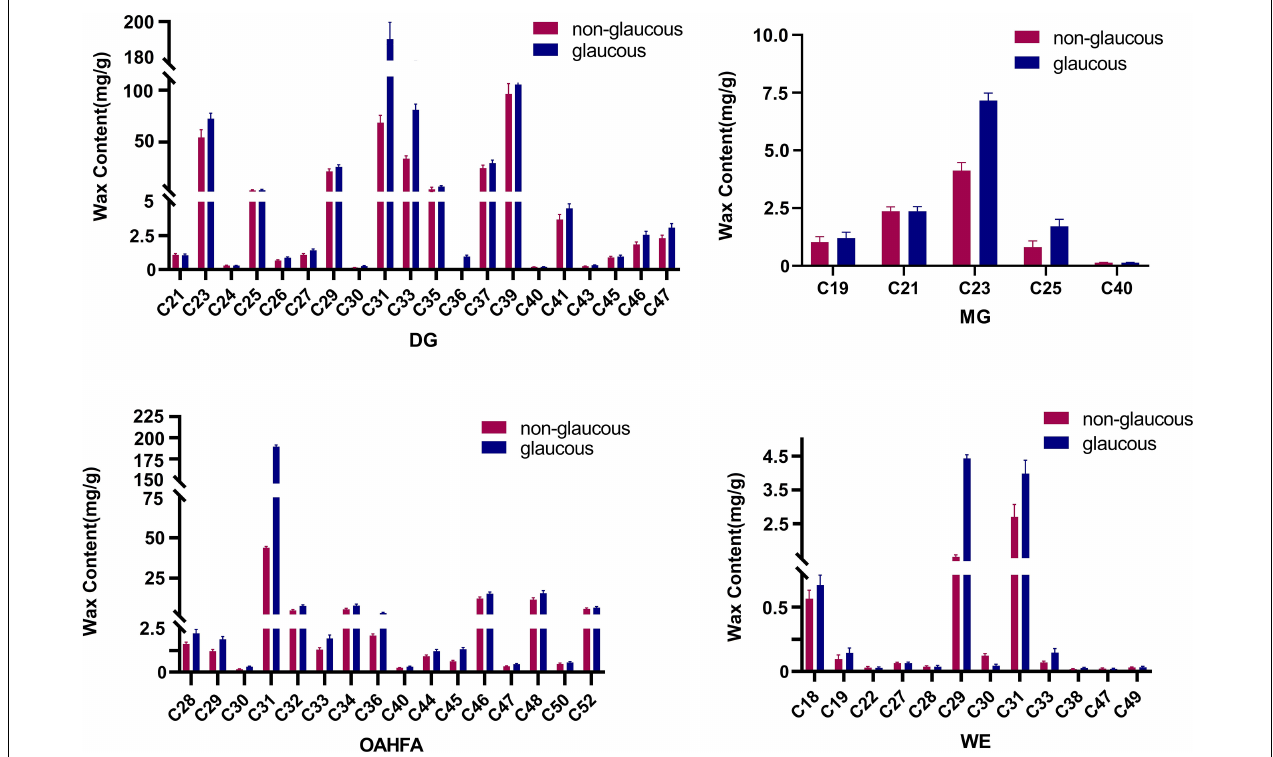
FIGURE 3 | The content of the main lipid molecules in cuticular wax of wheat flag leaves from non-glaucous Jinmai47 and glaucous Jinmai84. Major molecular species composition of DG (Diacylglycerols), MG (Monoradylglycerols), OAHFA [(O-acyl)- ω -hydroxy fatty acids], and WE (Wax ester) determined by UPLC-MS/MS.